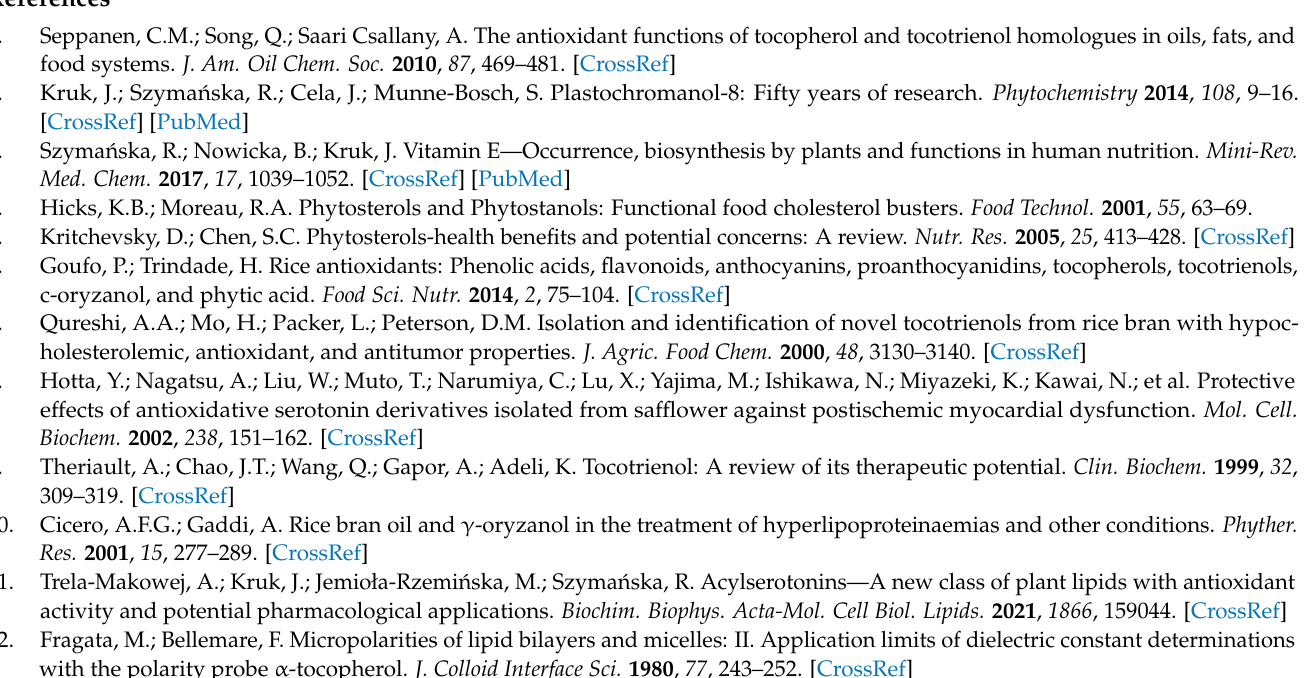
Figure S4: HPLC chromatograms of the extracts from whole seeds of tangerine, grapefruit and pomelo. Further details are given in the Materials and Methods